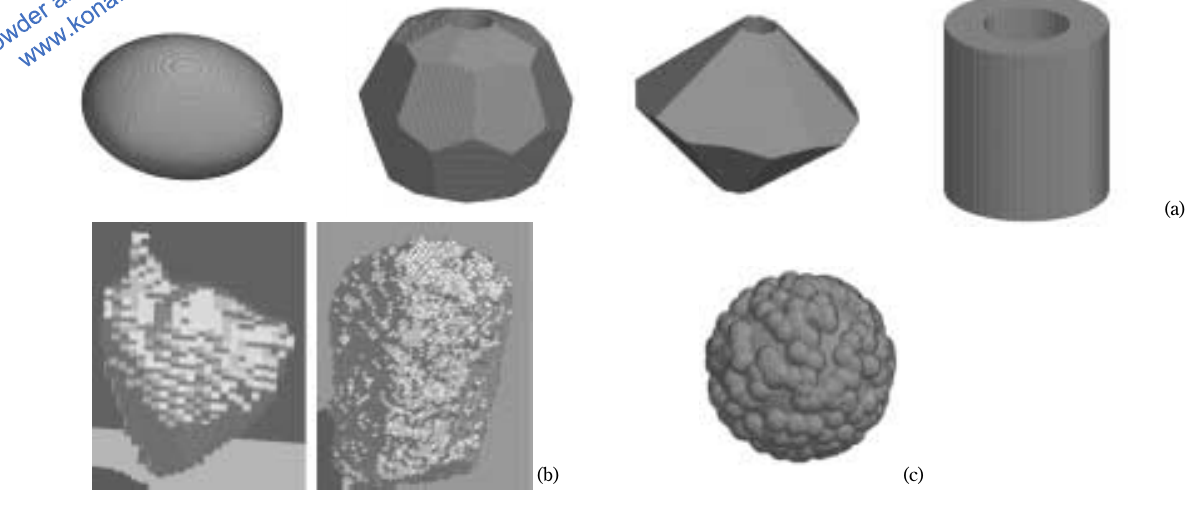
Fig. 2 Examples of digitised shapes used in the case studies. (a) Computer-generated replica of everyday objects. (b) XMT digitised shapes. (c) Shape generated using the SOS method.